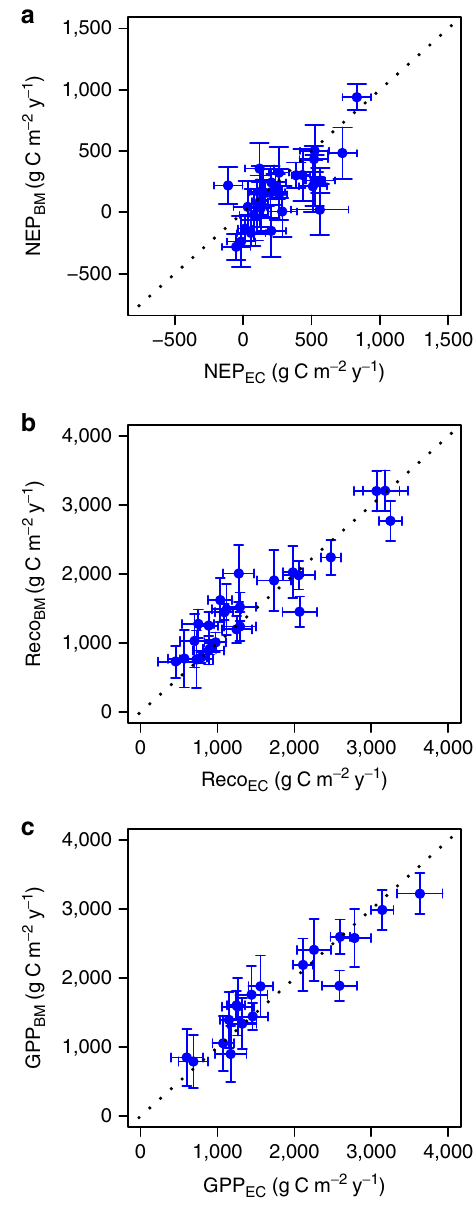
Figure 2 | Comparison of carbon fluxes obtained from eddy-covariance or biometric methods for worldwide forests. ( a ) Net ecosystem production (NEP, n ¼ 31), ( b ) ecosystem respiration (Reco, n ¼ 25) and ( c ) gross primary production (GPP, n ¼ 18) from eddy-covariance (EC; x axis) and biometric (BM; y axis) methods. Bars indicate confidence intervals which are derived from uncertainty ranges related to biome and latitude, constrained by a reduction factor depending on the methodology and by the number of replicate years of measurement (see Methods). The dotted line is the 1:1 (Fig. 2b). Reco BM was on average 13 ± 4% larger than Reco EC (marginally significant at P ¼ 0.061). Although the differences between EC- and BM-based estimates of Reco did not present any correlation with the indices of topographical complexity, LAI or any other environmental or stand variables (Table 3), Reco BM and Reco EC were significantly different for the boreal forests (difference 18 ± 7%, P ¼ 0.031) but were not significantly different for the temperate (16 ± 6%, P ¼ 0.079) and tropical forests (5 ± 5%, P ¼ 0.39) (Table 2).